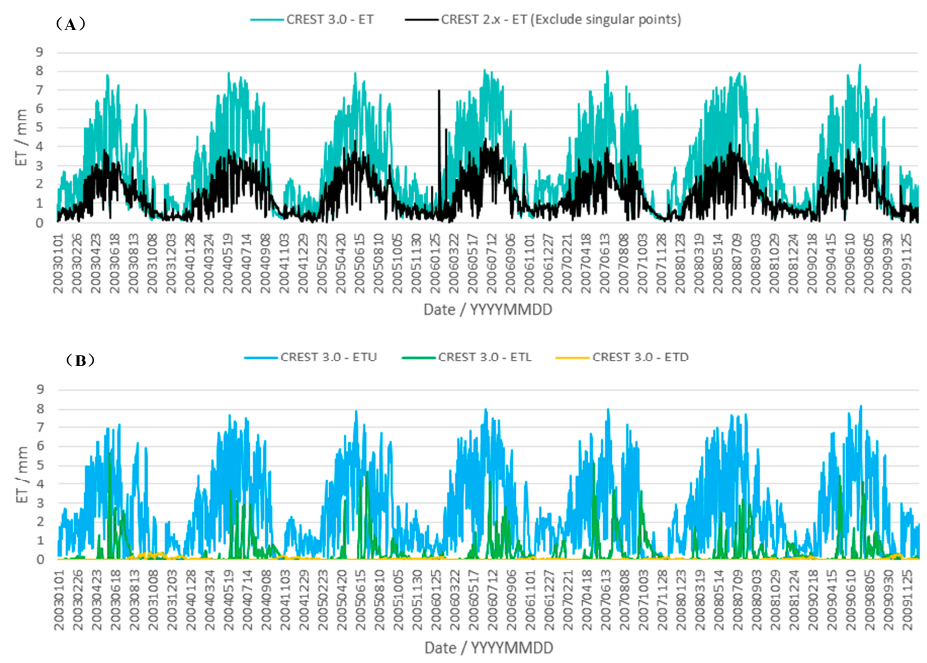
Figure 9. Simulated evapotranspiration of CREST 2.x (excluding singular points) and 3.0 models. ( A ) ET of CREST 2.x and 3.0; ( B ) ETU, ETL, and ETD of CREST 3.0. ETU: evapotranspiration of upper soil layer; ETL: evapotranspiration of lower soil layer; ETD: evapotranspiration of deep soil layer.